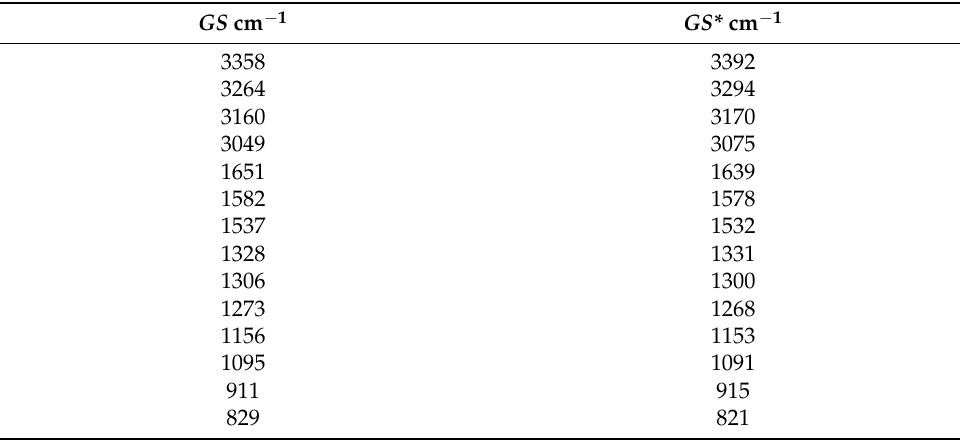
Table 4. Main peaks/bands of FT-IR spectra of GS and GS* (b) samples .